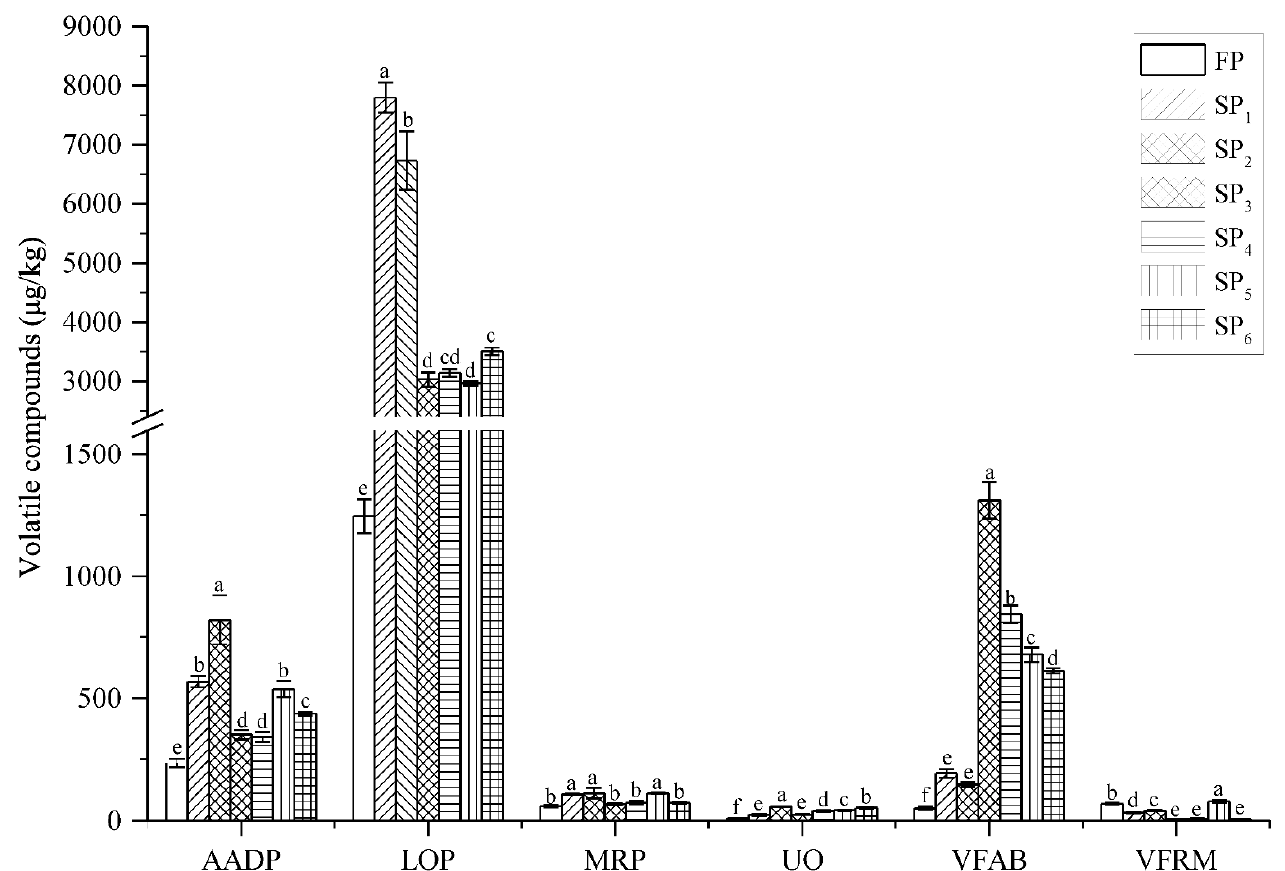
Figure 1. Concentration of volatile compounds according to possible origins of the fresh and stewed pork. Different letters are significantly different ( p < 0.05) in each pork treatment group. FP, fresh pork; SP 1 , boiled pork with water; SP 2 , cooked pork with water and salt; SP 3 , stewed pork with water, salt and spices; SP 4 , stewed pork with water, salt, spices and soy sauce; SP 5 , stewed pork with water, salt, spices, soy sauce and sugar; SP 6 , stewed pork with water, salt, spices, soy sauce, sugar and cooking wine. LOP, Lipid oxidation products; AADP, Amino acid degradation products; MRP, Maillard reaction products; VFAB, Volatiles from aged brine; VFRM, Volatiles from raw meat; UO, Unknown origin.